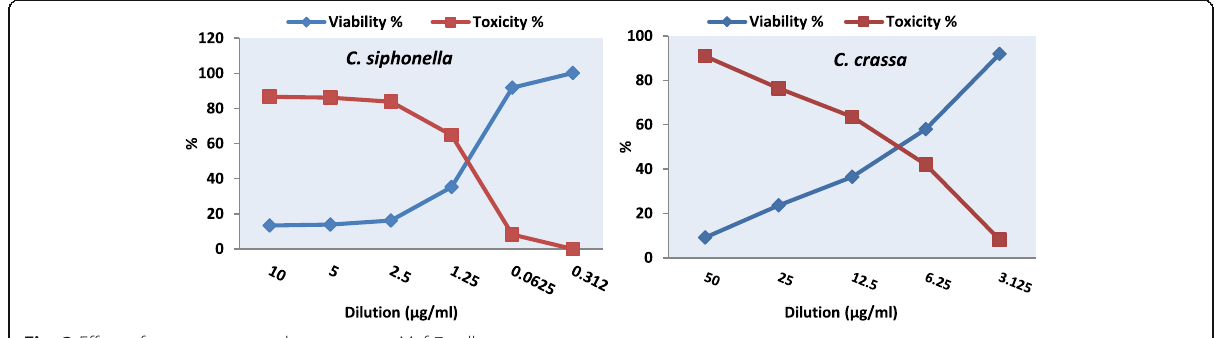
Fig. 3 Effect of two sponge crude extracts on Mcf-7 cells